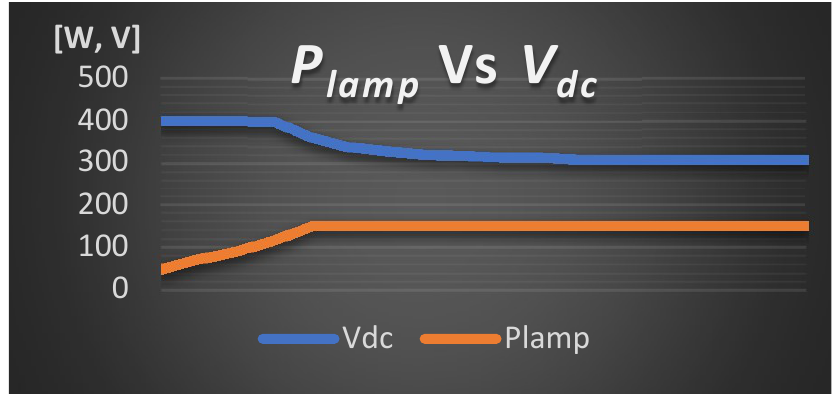
Figure 9. P lamp and V dc during the start-up and warm-up time of the lamp. The control scheme of the RI is shown in Figure 10. The microcontroller generates the RI control signal, RI_SIGNAL , adjusting it to the operating mode. Initially, when the lamp is turned off, the microcontroller generates a soft start-up sequence until the microcontroller detects that the lamp turns on with the signal LAMP_ON_INV and changes the RI operation mode to constant frequency f s = 250 kHz until the lamp reaches its nominal power, following the curves shown in Figure 9.